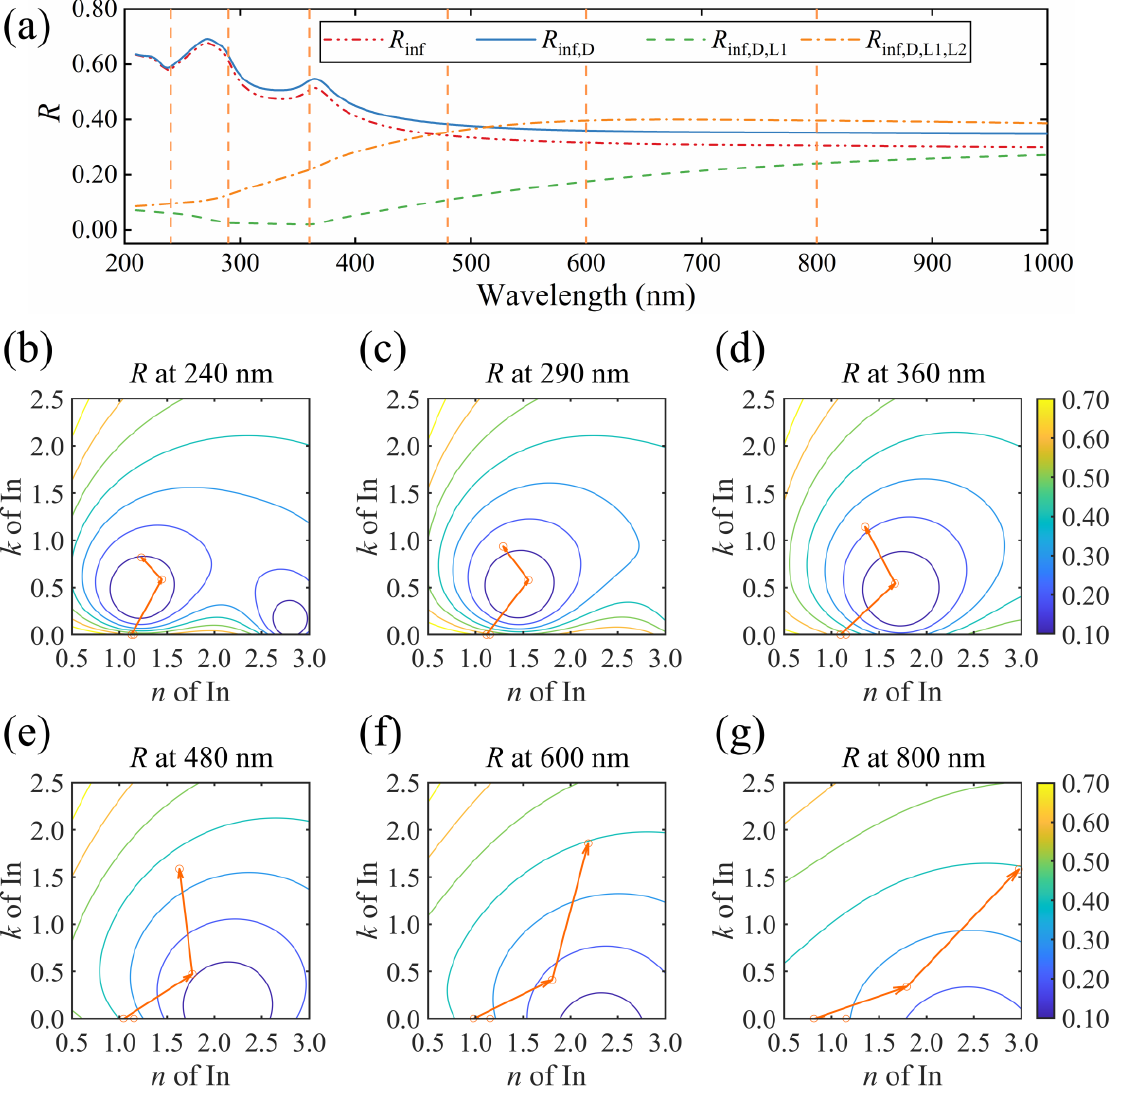
Figure 4. Reflectance spectra with different Lorentz oscillator components for ( a ) S2, and the oscillator decomposition at a wavelength of ( b ) 240, ( c ) 290, ( d ) 360, ( e ) 480, ( f ) 600 and ( g ) 800 nm. Curves in ( b ) – ( g ) are the contour lines of reflectance. Figure 4b–g display the vector decompositions and contour lines of reflectance at selective wavelengths of 240, 290, 360, 480, 600 and 800 nm, respectively. At each wave- length, the starting point marks the high-frequency optical constant ( n inf , k inf ). The